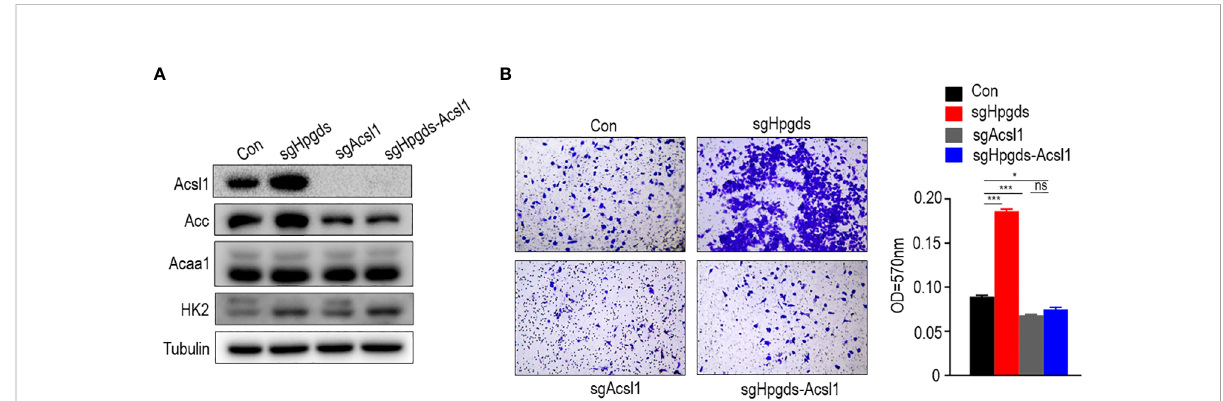
FIGURE 7 (A, B) Knockdown of HPGDS promoted migration by upregulate the expression of the lipid metabolism key enzyme ACSL1 and ACC, but not for HK2 and ACAA1. ns (no sense) P > 0.05, *P < 0.05, ***P <